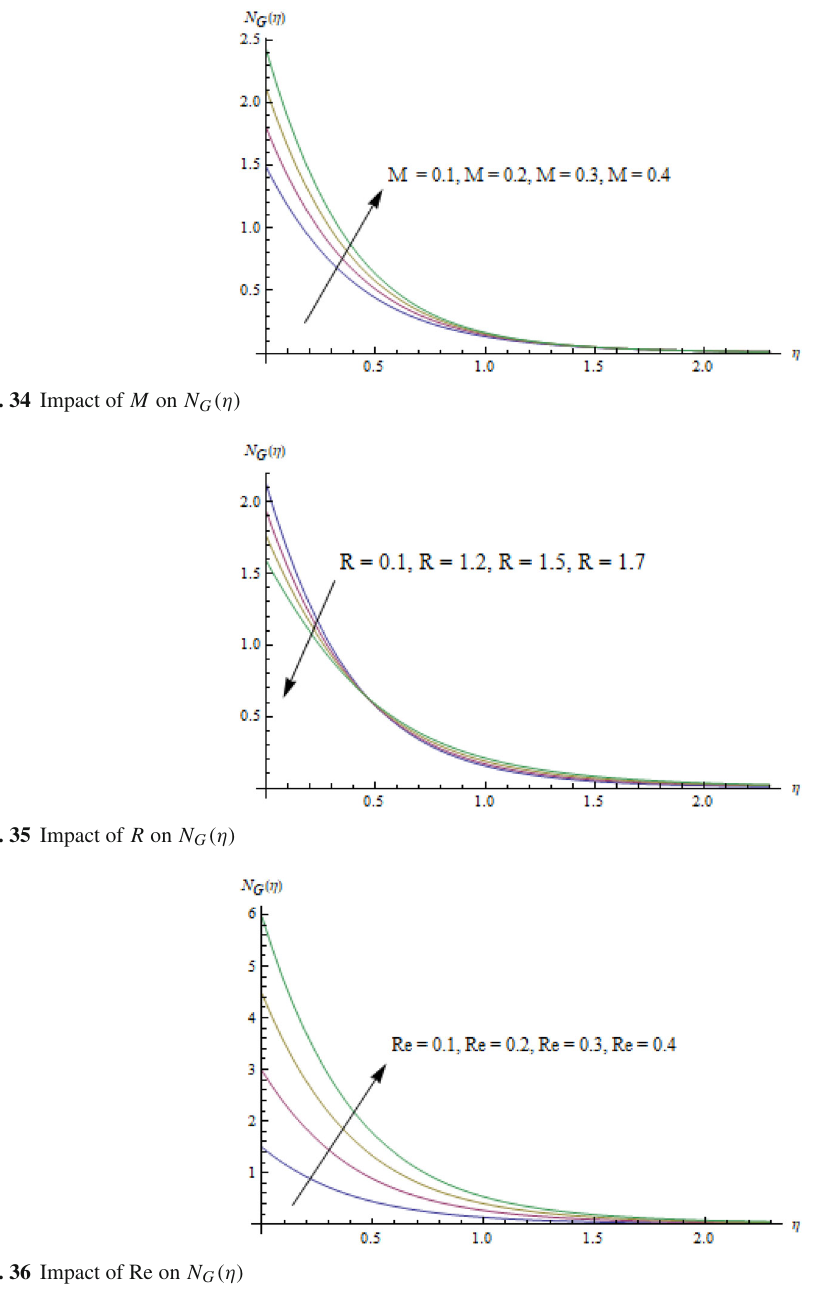
Fig. 36 Impact of Re on N G